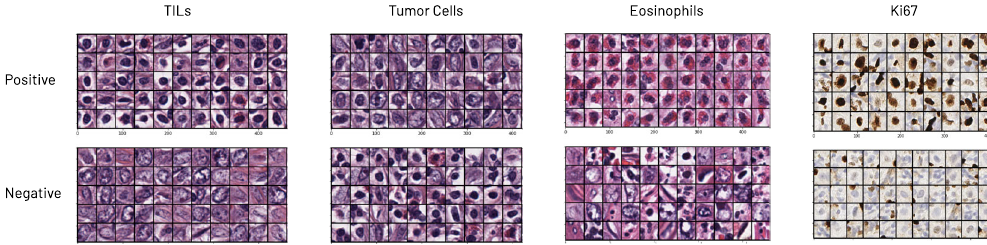
Fig. 3 Experimental use-cases. The task of cellular annotation is chosen, speci fi cally owing to its highly repetitive nature, and the dif fi culty of complete data annotation (e.g., a section of tissue may contain 900,000 cells). Four use-cases highlight the generalizability of this method across stain types and cell types. From left to right: tumor-in fi ltrating lymphocytes (TILs), tumor cells, eosinophils, and Ki-67-stained cells of arbitrarily suf fi cient size, as determined by the annotators. Top row shows example cells of the speci fi ed type (positive), the bottom row shows examples of all others (negative). See Data Availability for image